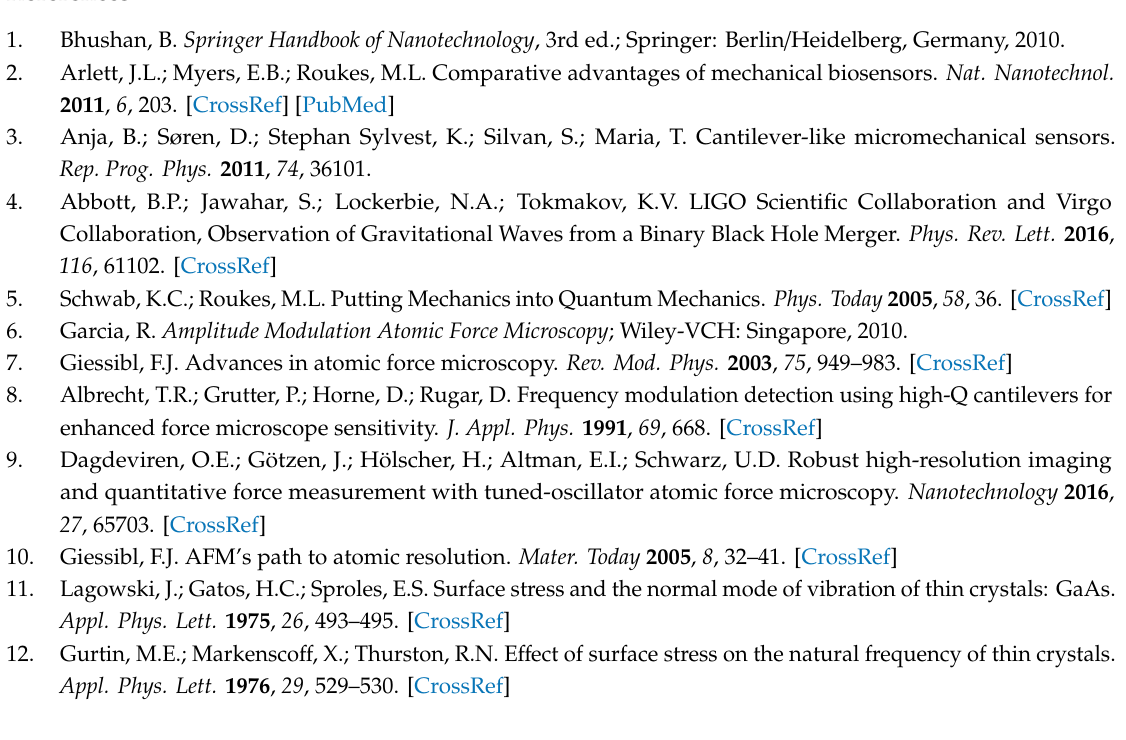
Figure S1: Schematic representation of tuning forks in the qPlus configuration. Figure S2: The measurement of the resonance frequency of an encapsulated tuning fork as a function of oscillation amplitude. Figure S3: The measurement of the resonance frequency of a tuning fork in qPlus configuration. Figure S4: The measurement of the resonance frequency of a tuning fork in qPlus configuration. Figure S5: The measurement of the resonance frequency of a microfabricated silicon cantilever-I (OPUS 4XC-NN-A) as a function of oscillation amplitude. Figure S6: The assembled sensor setup and the modelling procedure to determine the modal shape and the surface stress distribution of tuning fork-based sensors. Figure S7: Calibration of spring constant with finite element methods. Figure S8: Summary of the algorithm to correct the resonance frequency shift data to eliminate the e ff ect of the amplitude dependence of the resonance frequency. Table S1: Dimensions of tuning forks are measured with a calibrated light microscope. Table S2: Material properties used for finite element method (FEM) calculations. Author